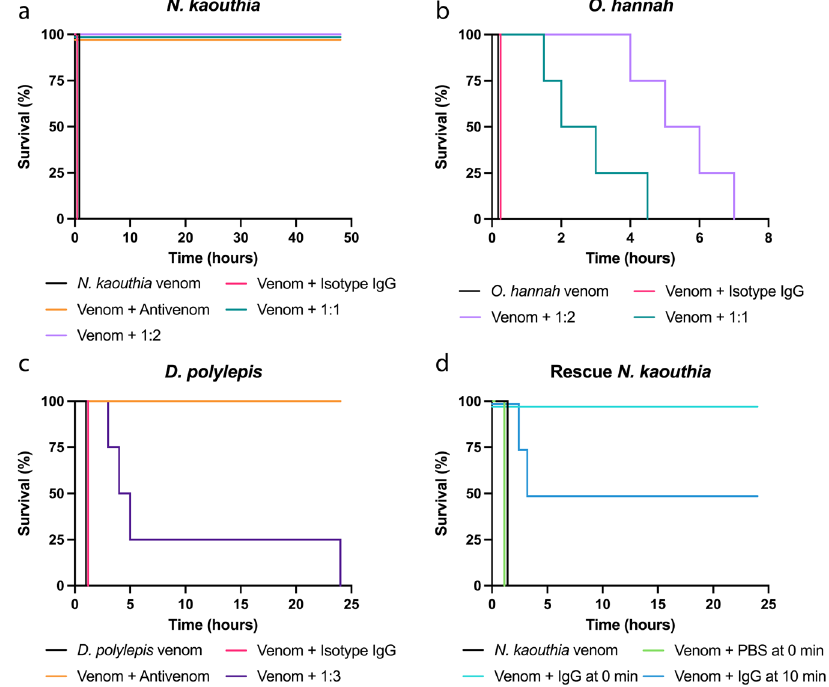
Fig. 6 | Kaplan – Meier survival curves for envenomed mice treated with the antibody 2554_01_D11. a – c Mixtures containing 2 LD 50 s of venom of either N. kaouthia , O. hannah , or D. polylepis were preincubated with the antibody, 2554_01_D11, at various neurotoxin:antibody ratios and then administered i.v. into groups of four mice. Controls included mice receiving venom alone, or venom incubated with either an irrelevant isotype antibody control or commercial horse- derived antivenoms (see Materials and Methods for details). Signs of toxicity were observed, and deaths were recorded for a maximum period of 48h. d N.